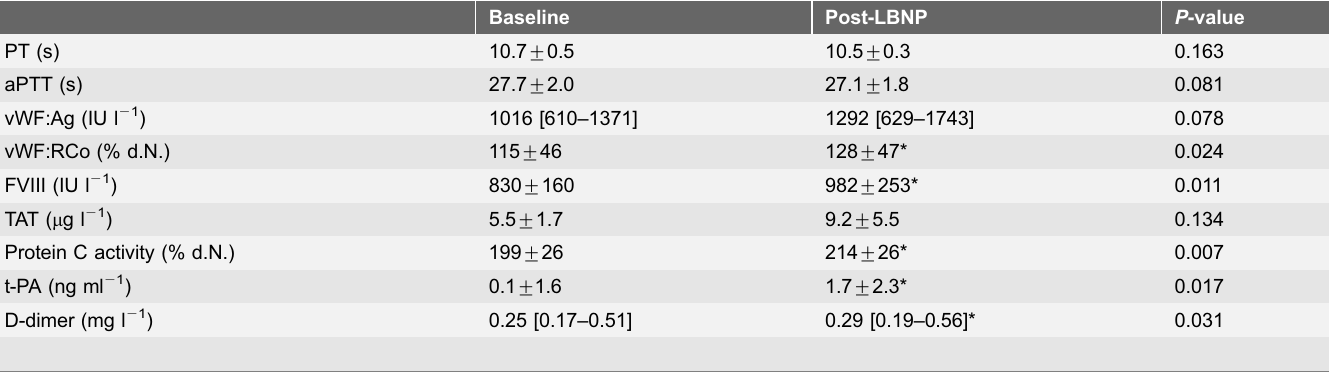
Table 3. Plasma markers of hemostatic activity before and 5 min after lower body negative pressure (post-LBNP) was ceased because of presyncopal symptoms. Baseline